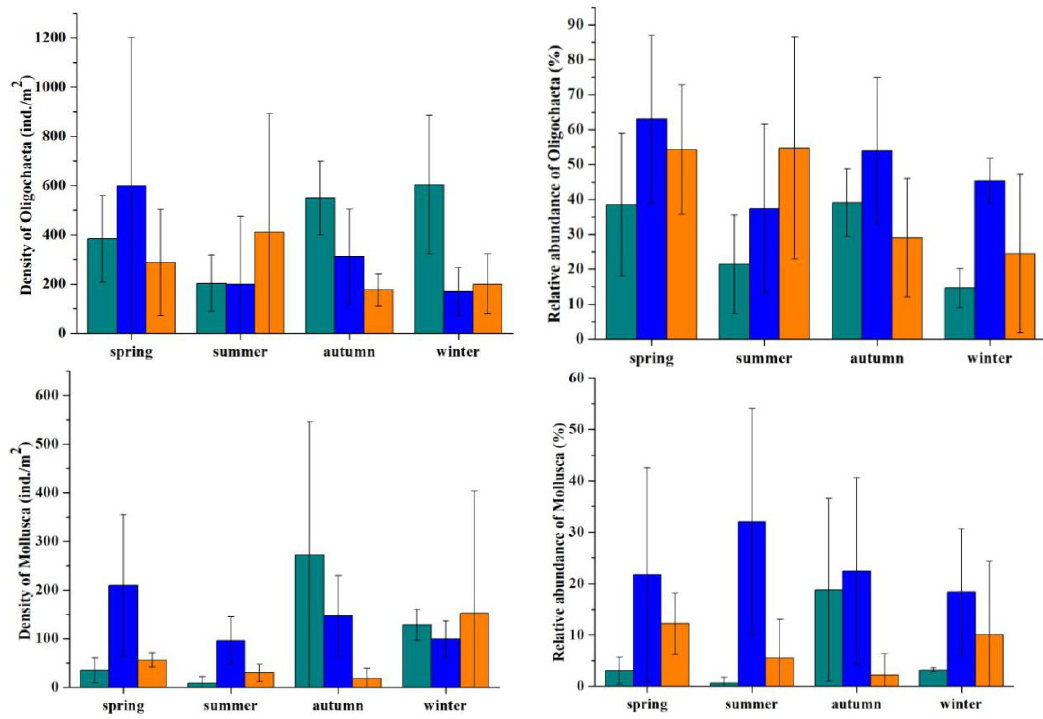
Figure 2. Spatial and temporal variations of macroinvertebrate biomass, density, biodiversity indices, and main taxa groups (density and relative abundance of Chironomidae, Oligochaeta and Mollusca).